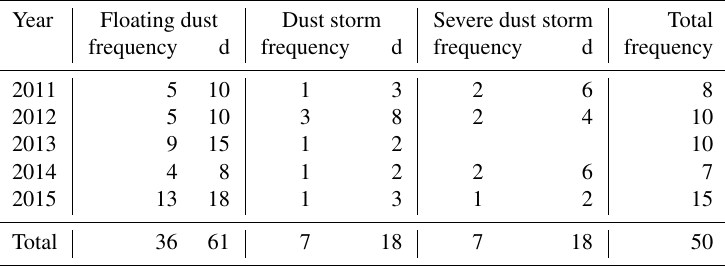
Table 2. Summary of dust weather conditions in China during